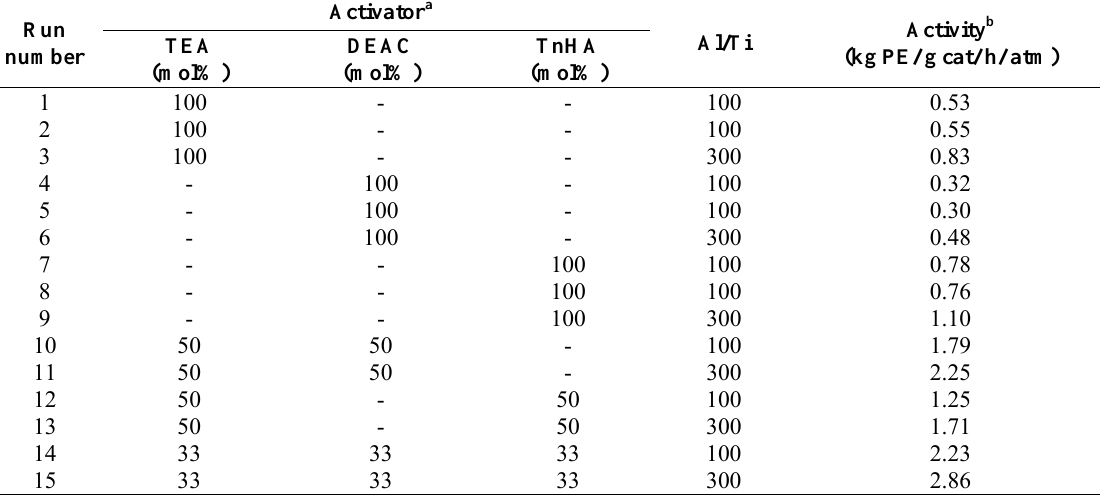
Table 1. Description of ethylene polymerization with various